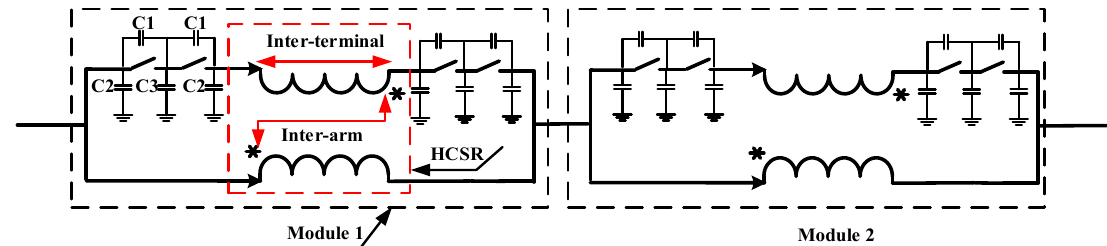
Figure 1. Topology of the 500 kV power system.